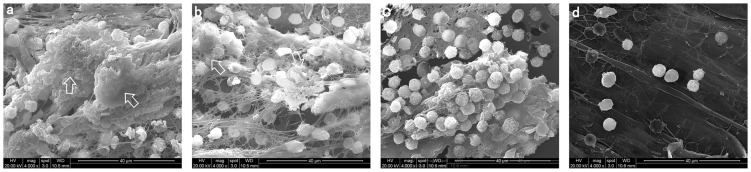
SEM images of biofilms and attached Staphylococcus epidermidis on the implant washers.Arrows indicate Staphylococcus epidermidis biofilm on the washers. Representative SEM images from animals received intra-articular lavage with normal saline (a), vancomycin (b), allicin (c) and allicin plus vancomycin (d) are shown. The magnifications are X1000for all images.